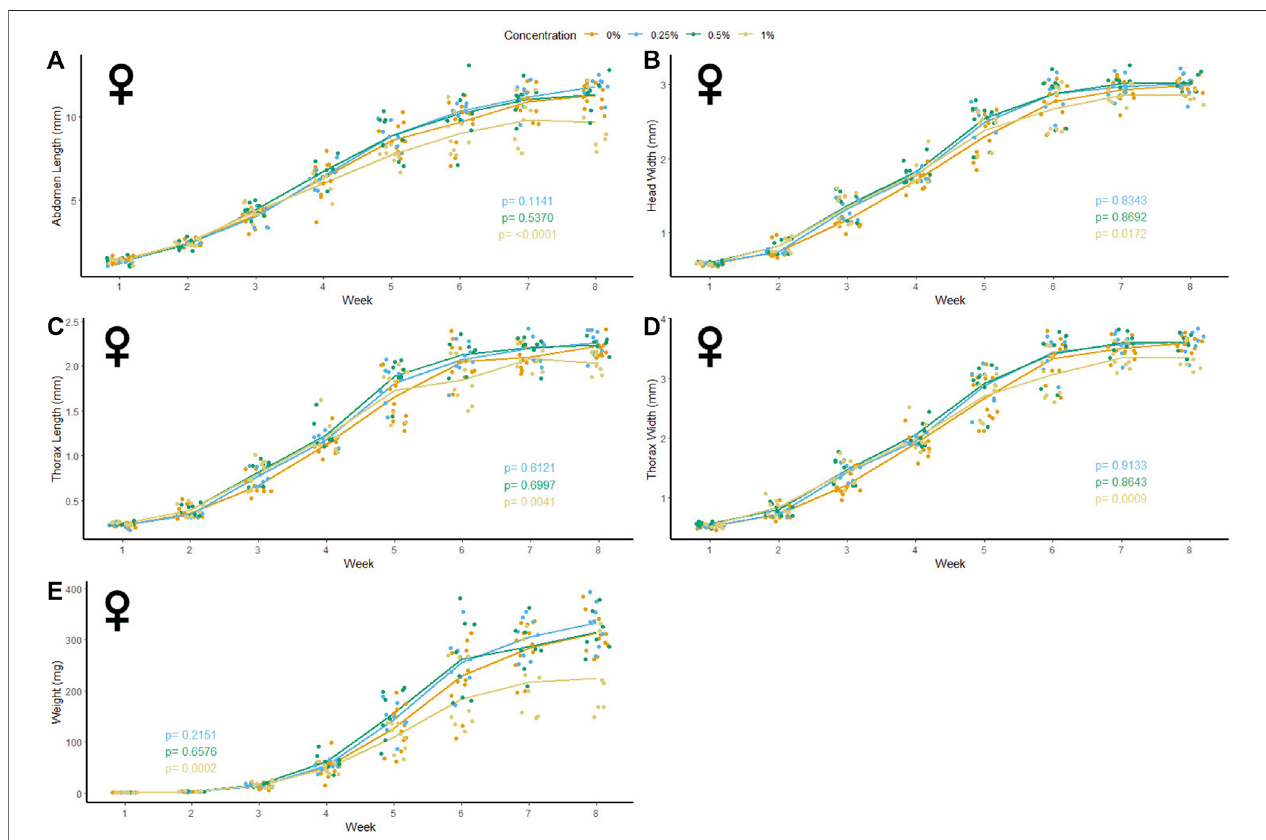
FIGURE 5 | Body size and mass of female Gryllodes sigillatus fed a diet containing PET micro fi bers. Initial measurements of crickets were taken once cricket nymphs emerged from eggs at week 1. Points represent individual cricket measurement and lines represent mean values between measurements. p -values are presented as an interaction of the concentration of PET micro fi ber with the week of growth. Each panel displays a different measure of body size with (A) = abdomen length, (B) = head width, (C) = thorax length, (D) = thorax width, (E) =